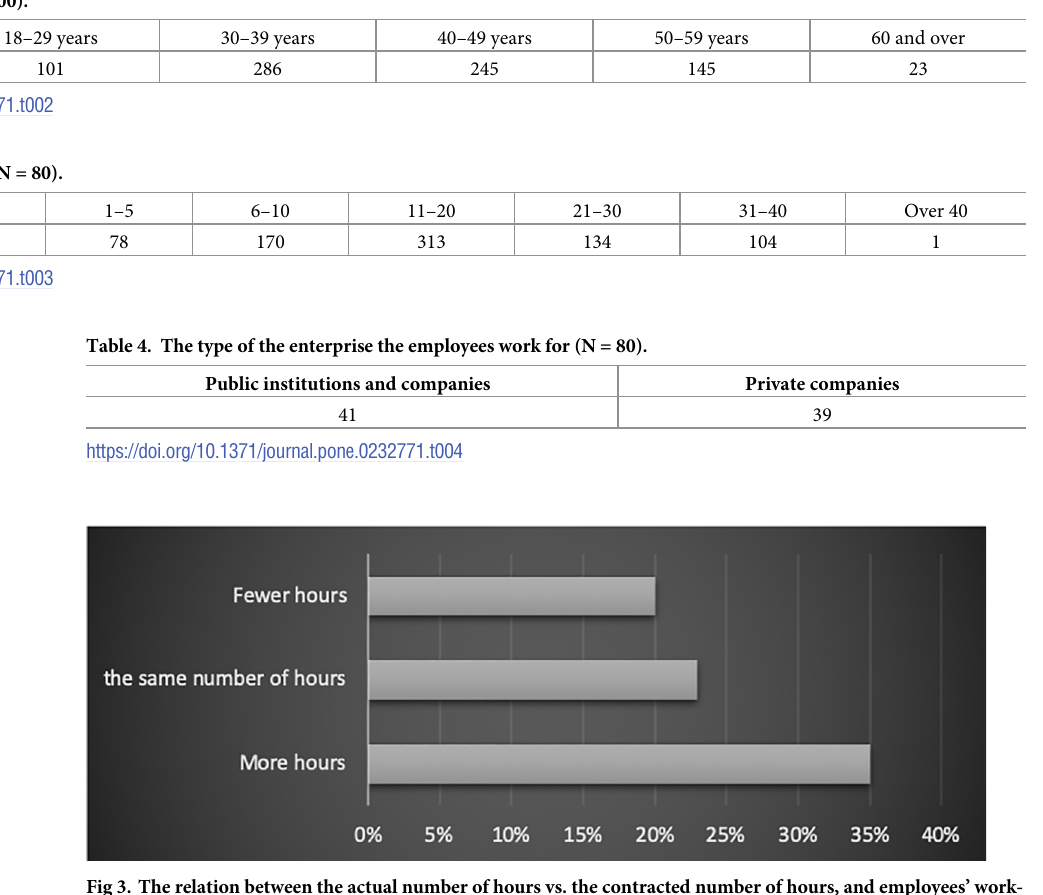
Fig 3. The relation between the actual number of hours vs. the contracted number of hours, and employees’ work- life balance (% of people in the category).